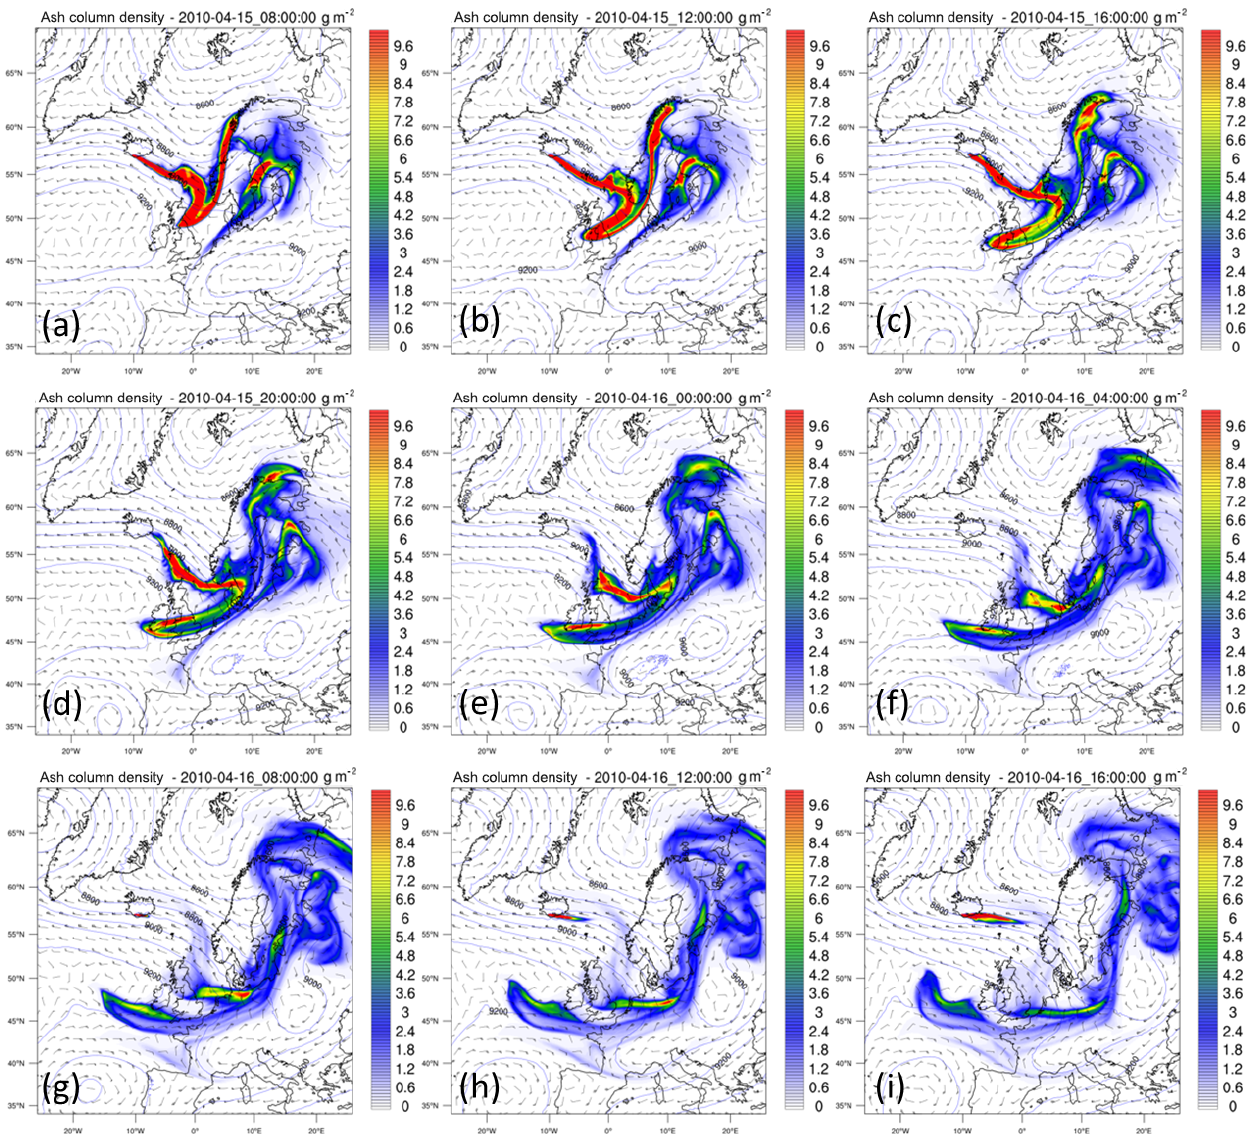
Figure 7. WRF-Chem-generated volcanic ash column densities for the Eyjafjallajökull eruption in April 2010 at 4h intervals: (a) 15 April at 08:00UTC, (b) 15 April at 12:00UTC, (c) 15 April at 16:00UTC, (d) 15 April at 20:00UTC, (e) 16 April at 00:00UTC, (f) 16 April at 04:00UTC, (g) 16 April at 08:00UTC, (h) 16 April at 12:00UTC, and (i) 16 April at